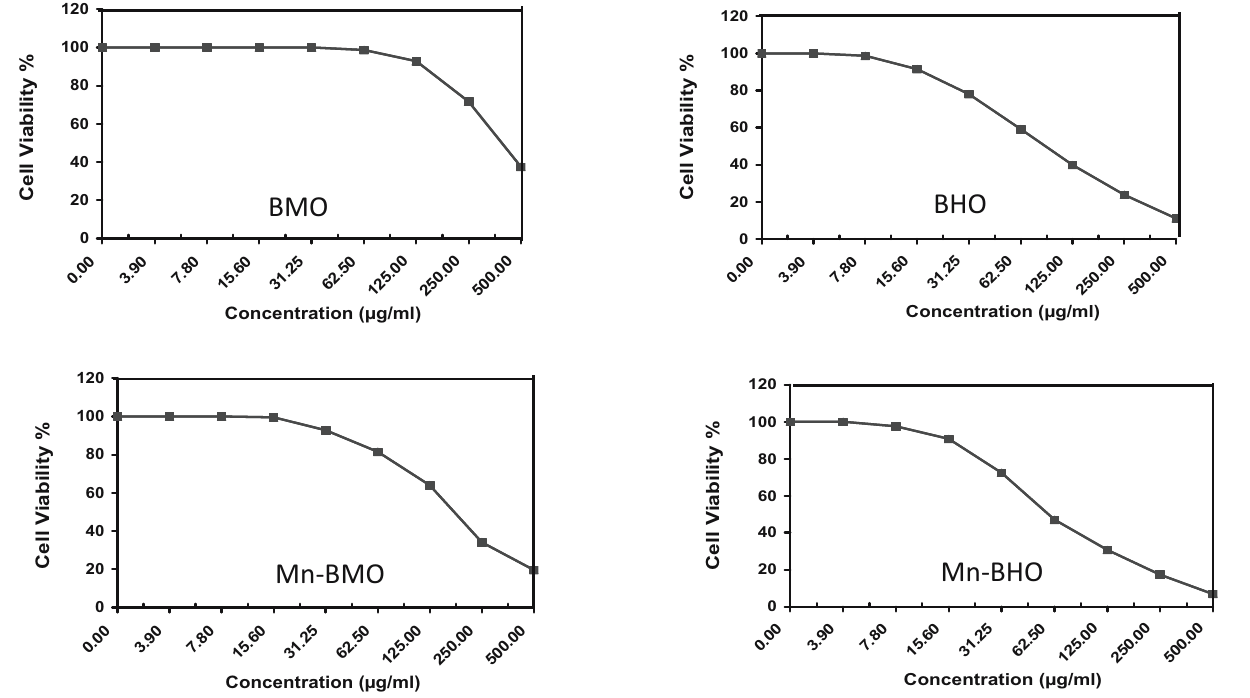
Figure 8: Cytotoxicity evaluation of ligands and their manganese ( II ) complexes against M - NFS - 60 cell